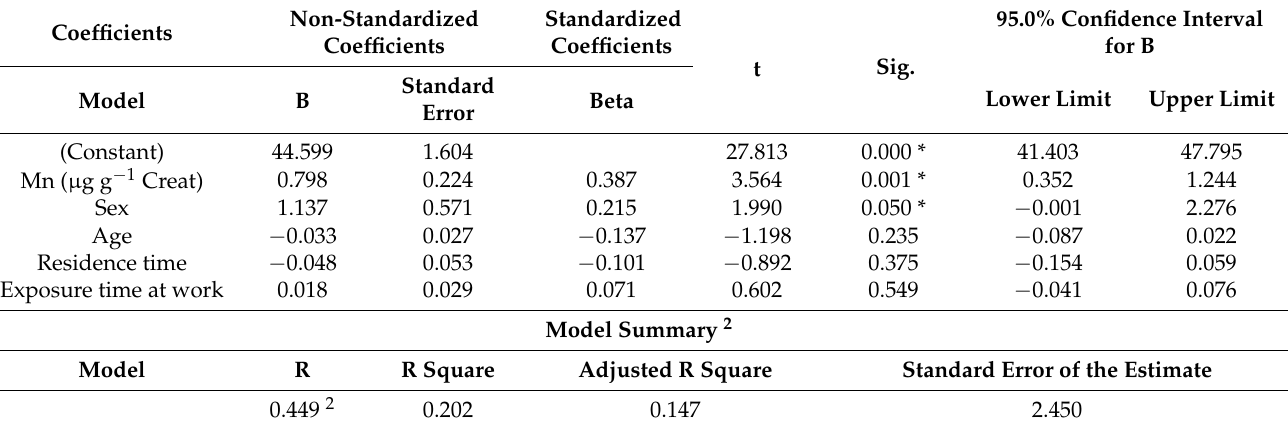
Table 6. Linear regression of the independent factors associated with chronotypes 1 .